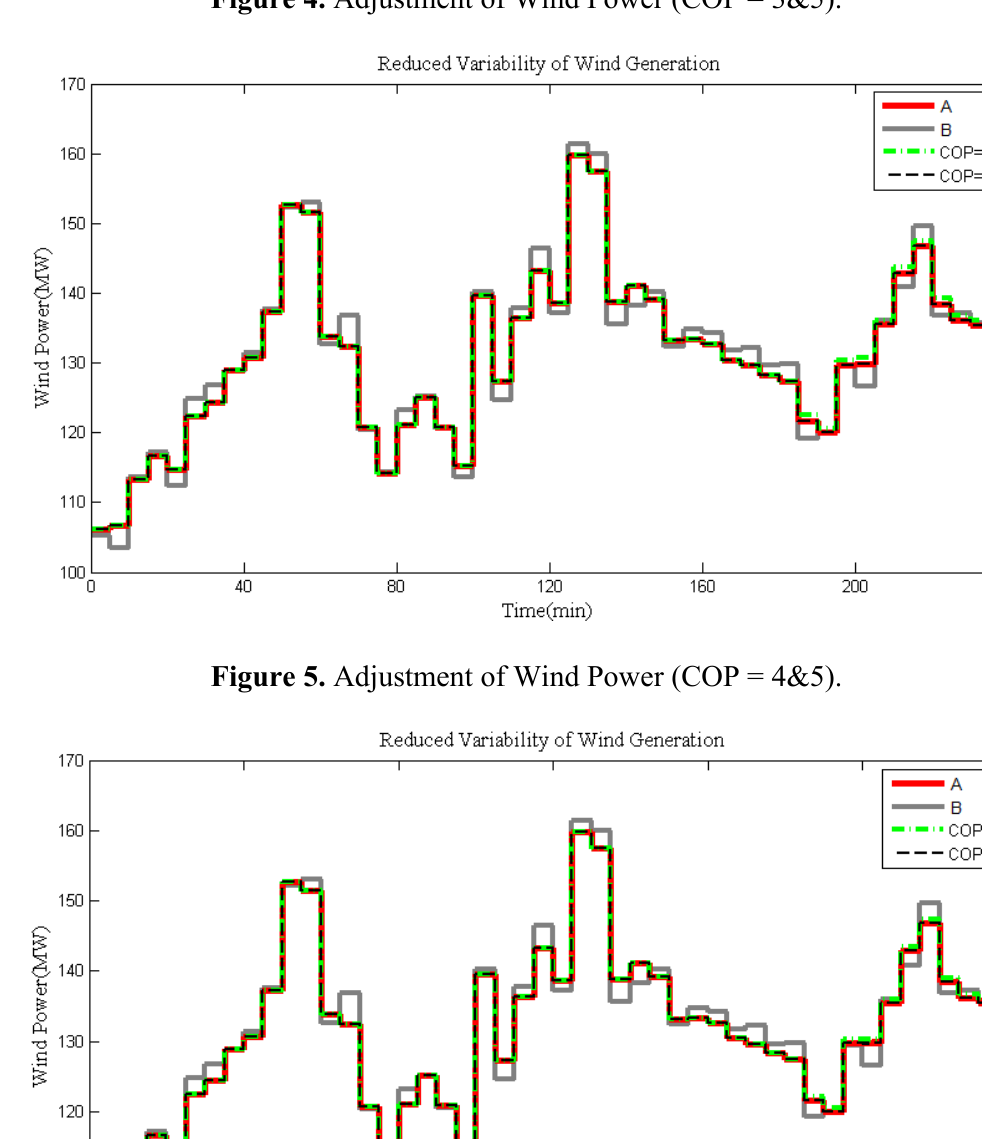
Figure 4. Adjustment of Wind Power (COP = 3&5).